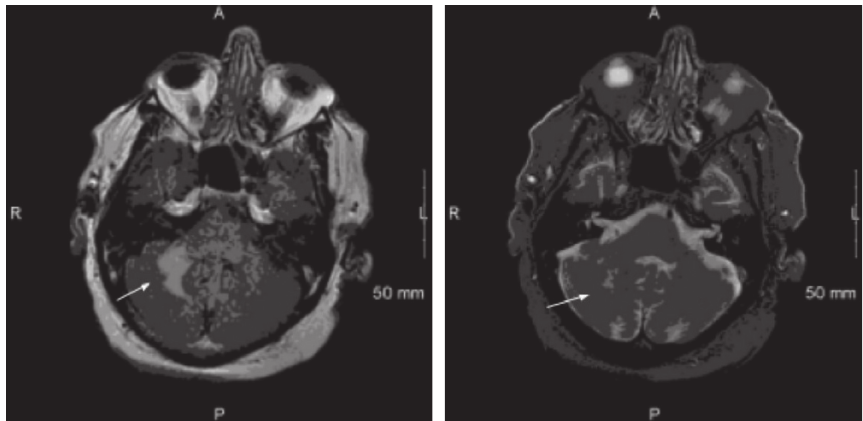
Figure 1: T2 and FLAIR magnetic resonance imaging (MRI) showing a hyperintense lesion without mass effect in the right cerebellar hemisphere.